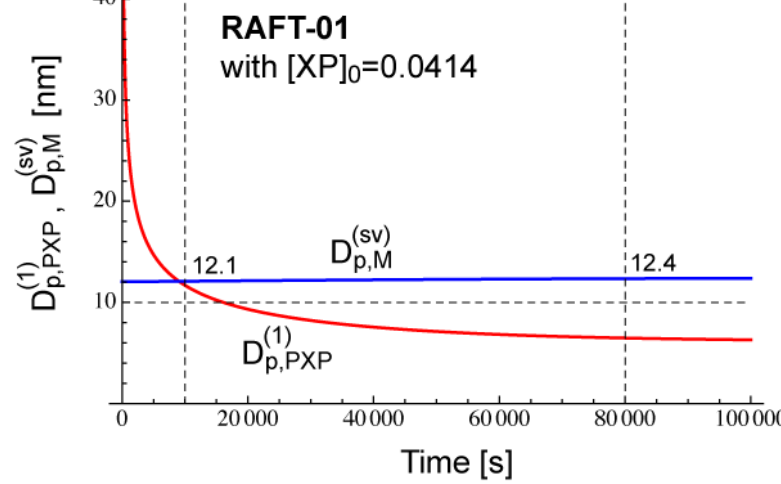
Figure 21. Calculated time development of (cid:1830) (cid:2926),PXP(cid:4666)(cid:2869)(cid:4667) and (cid:1830) (cid:2926),M(cid:4666)(cid:2929)(cid:2932)(cid:4667) with [XP] The (cid:1830) (cid:2926),M(cid:4666)(cid:2929)(cid:2932)(cid:4667) -values at t = 1 × 10 4 and 8 × 10 4 s are shown in the figure.